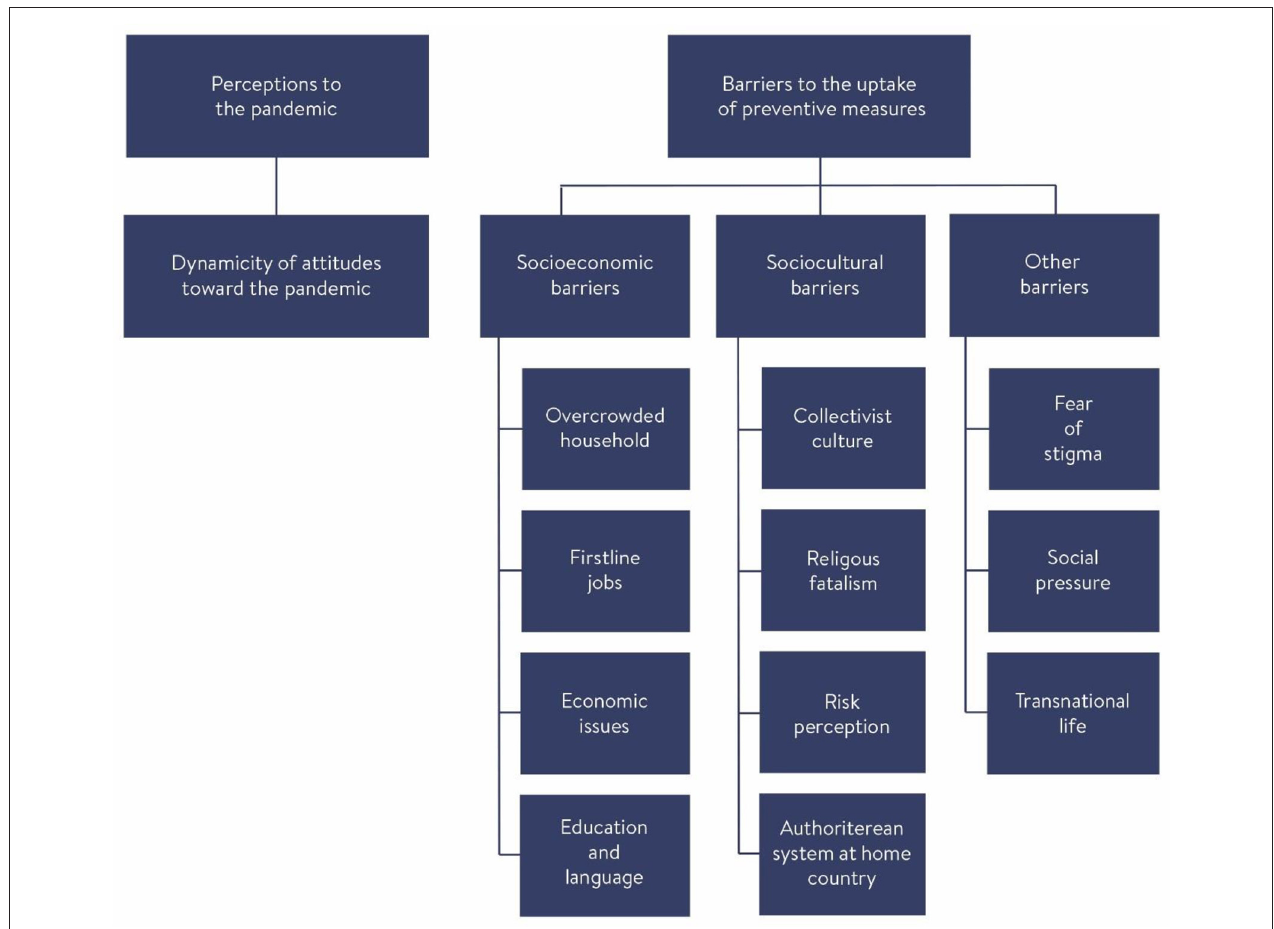
FIGURE 1 | Themes, subthemes, and